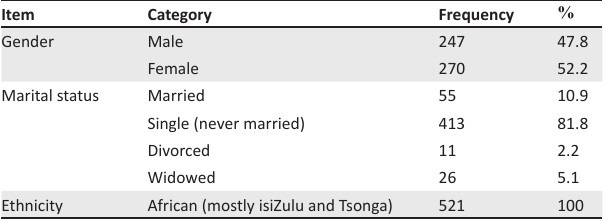
TABLE 1: Social and biographical characteristics of participants.